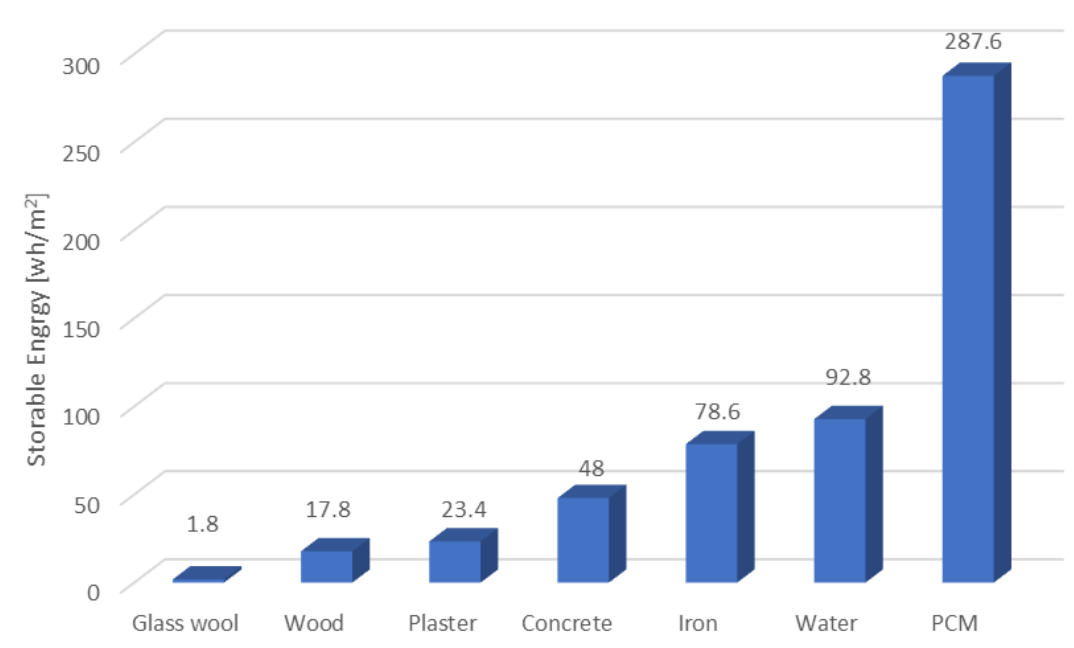
Figure 19. Heat storage capacity of different building materials between 18 °C and 26 °C for a period of 24 h. This figure was redrawn based on [111].